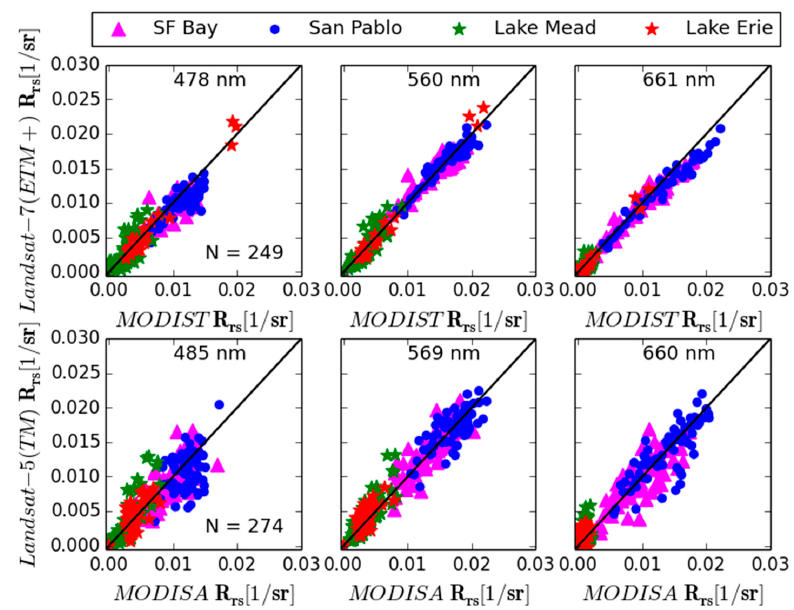
Figure 9. The scatterplots for the TM-MODISA and MODIST-ETM+ intercomparisons. Considering the dynamic range in the signal and the uncertainties in the intercomparisons, TM and ETM+ products are in good agreement with those of MODIS. The largest scatter is found in TM-derived R rs (485) products. The larger uncertainties in the TM-MODISA analyses have aroused from two-to-three-hour time difference in their respective overpass times.